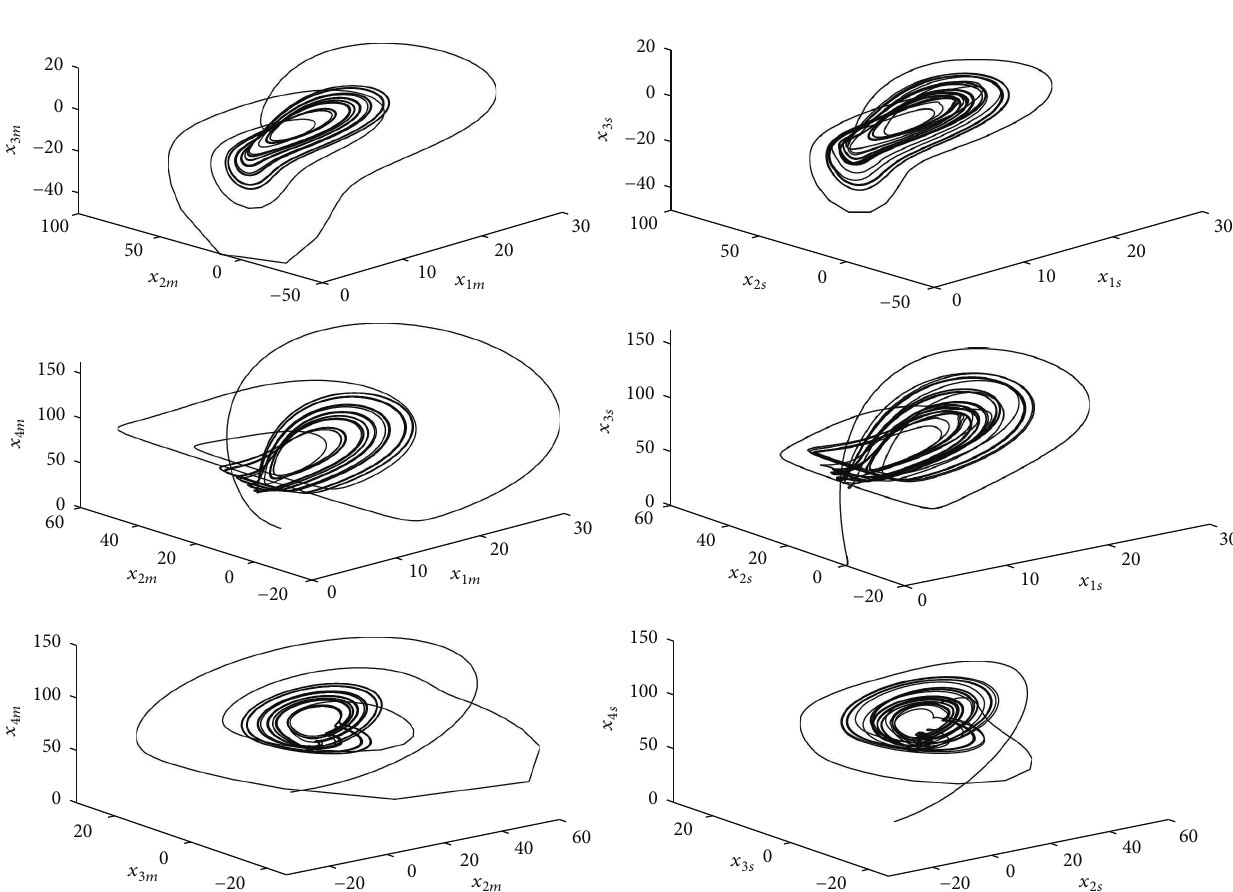
Figure 5: Phase portrait of the synchronization of the hyperchaotic Lorenz-Haken system (17) and its observer (18). The subscripts 𝑚 and 𝑠 represent the variables of master and slave systems (17) and (18),